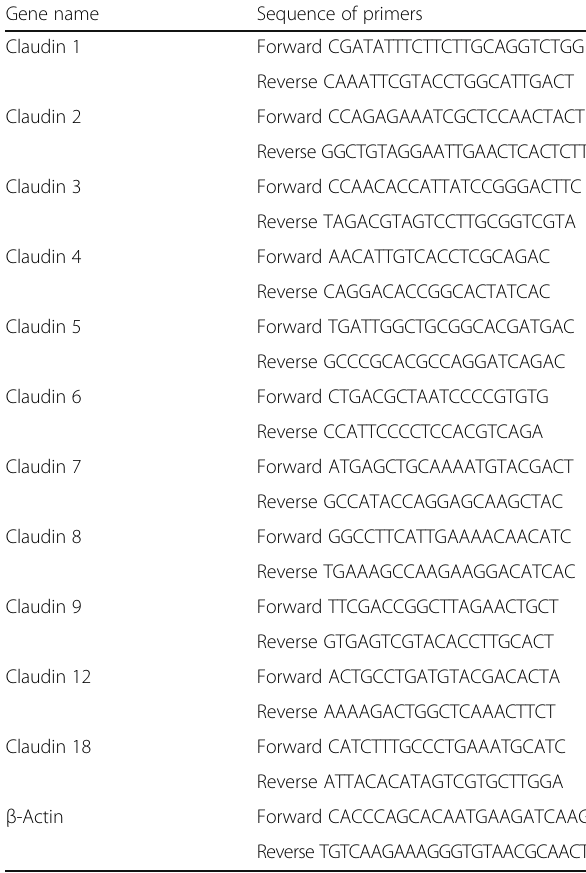
Table 2 Sequences of primers used in the real-time quantitative